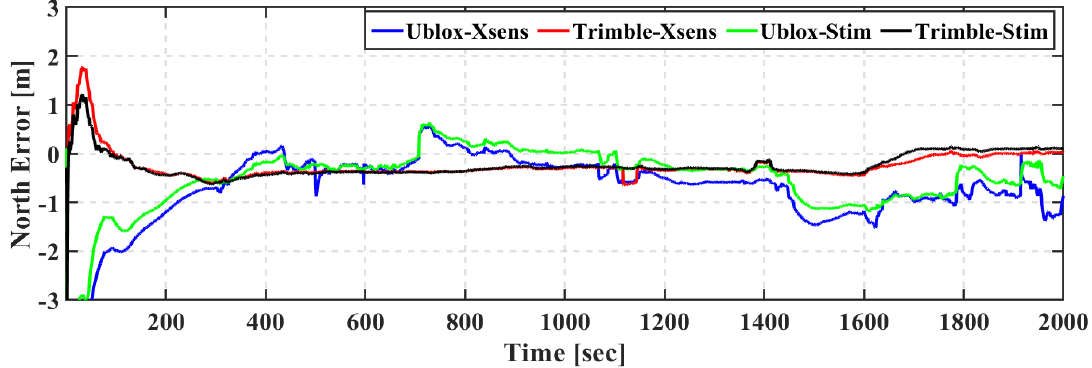
Figure 20. Third field trial: East positioning error of real-time TC GNSS PPP/INS for Ublox–Xsens, Trimble–Xsens, Ublox–Stim, and Trimble–Stim solutions.